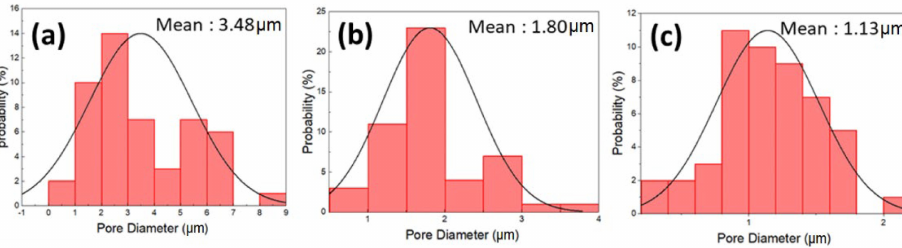
Figure 1. SEM images of porous PSF membranes: ( a ) 12 wt.%; ( b ) 16 wt.%; ( c ) 20 wt.% PSF in DMF.